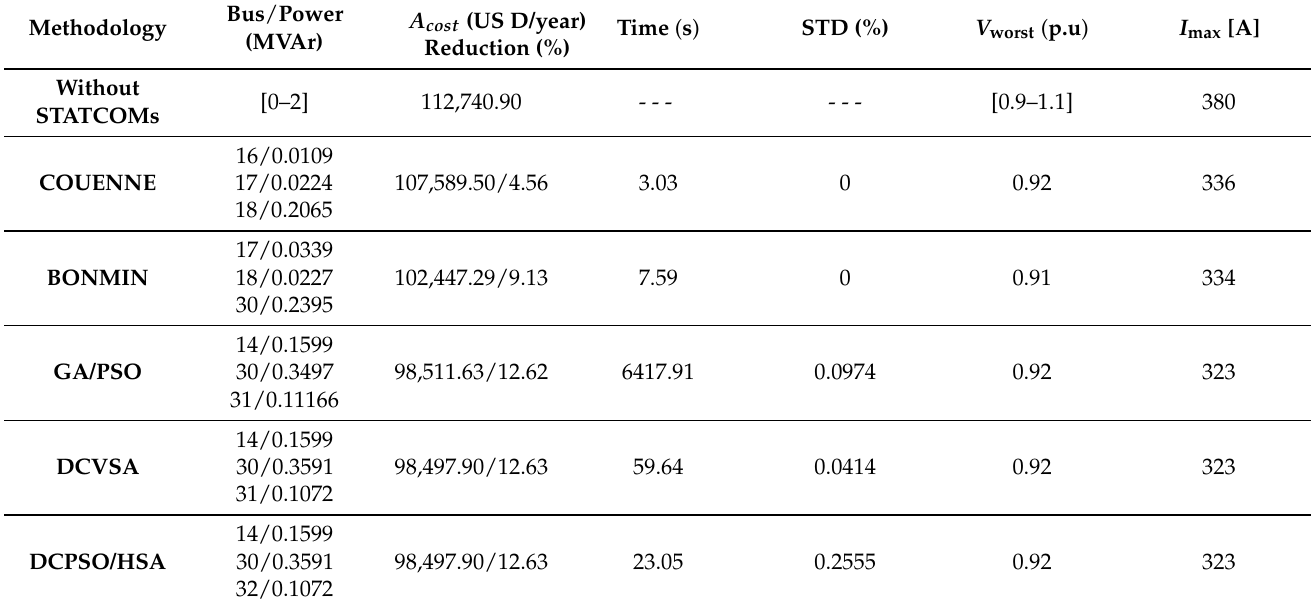
Table 3. Simulation results obtained by different methodologies in the 33-bus test